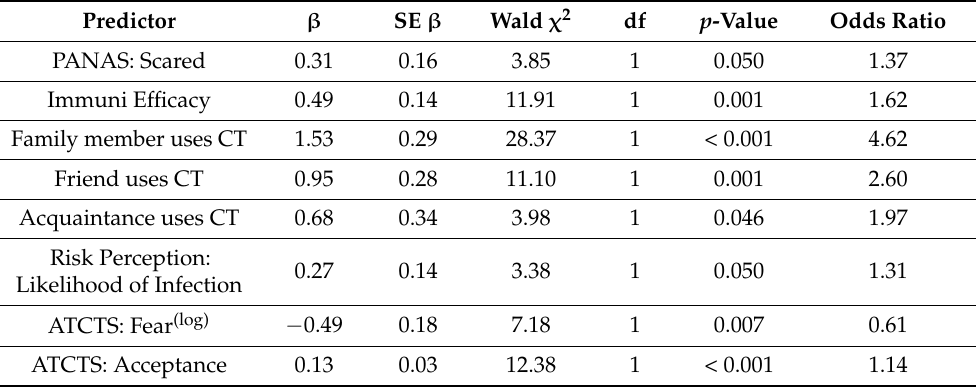
Table 2. Logistic regression model for Immuni